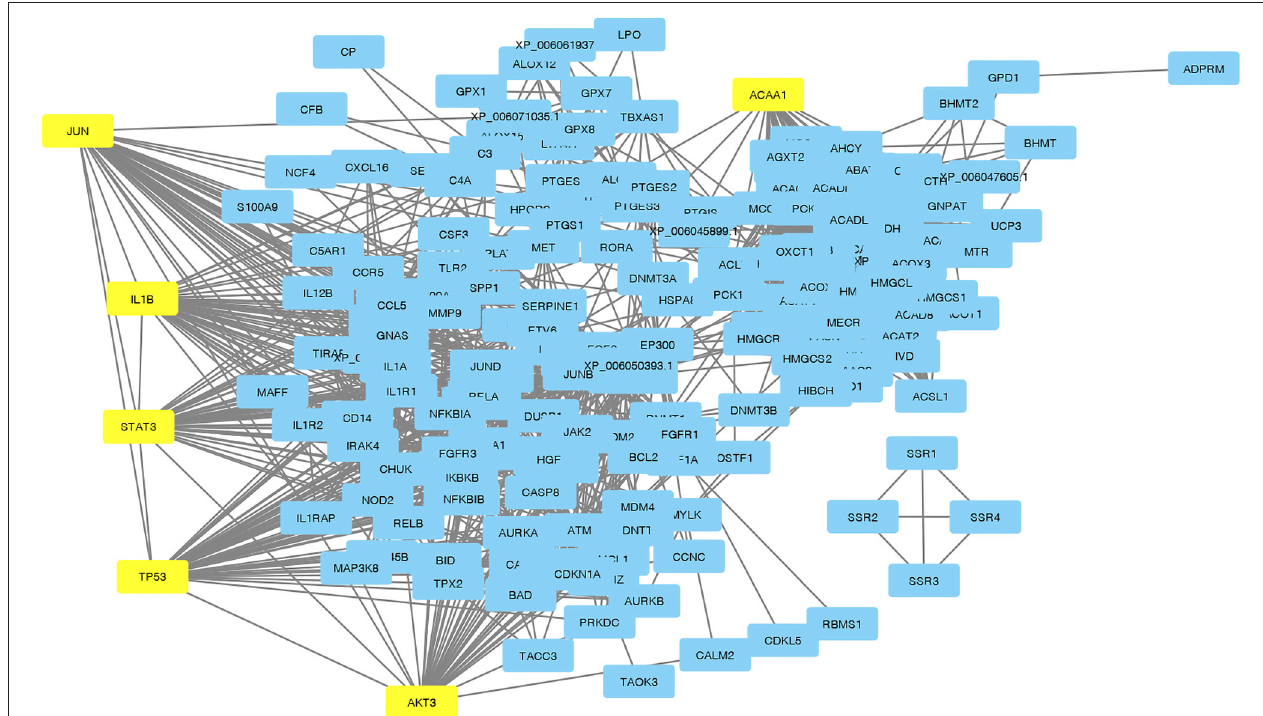
FIGURE 4 | Protein-protein interactions with hub genes highlighted in